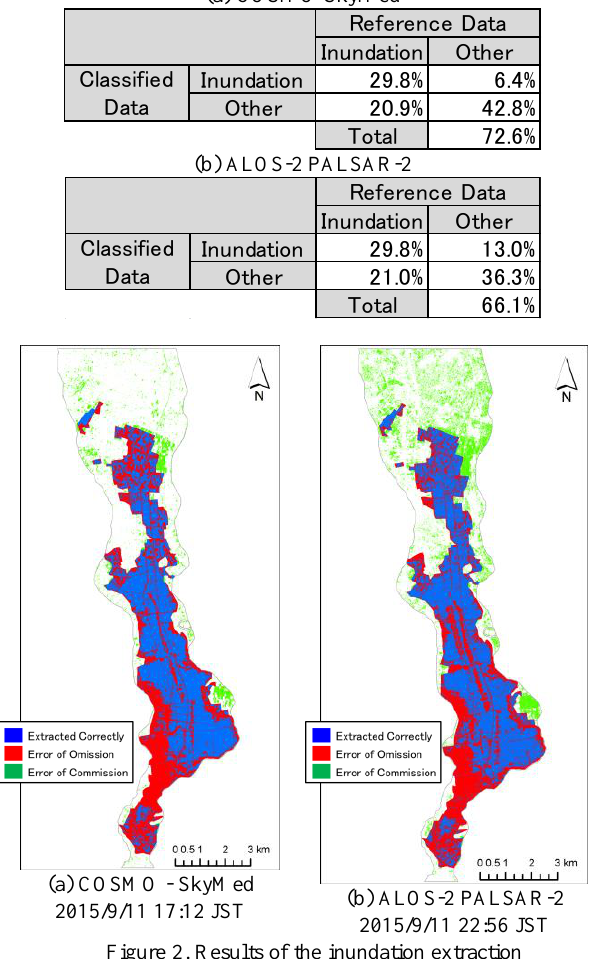
Figure 2. Results of the inundation